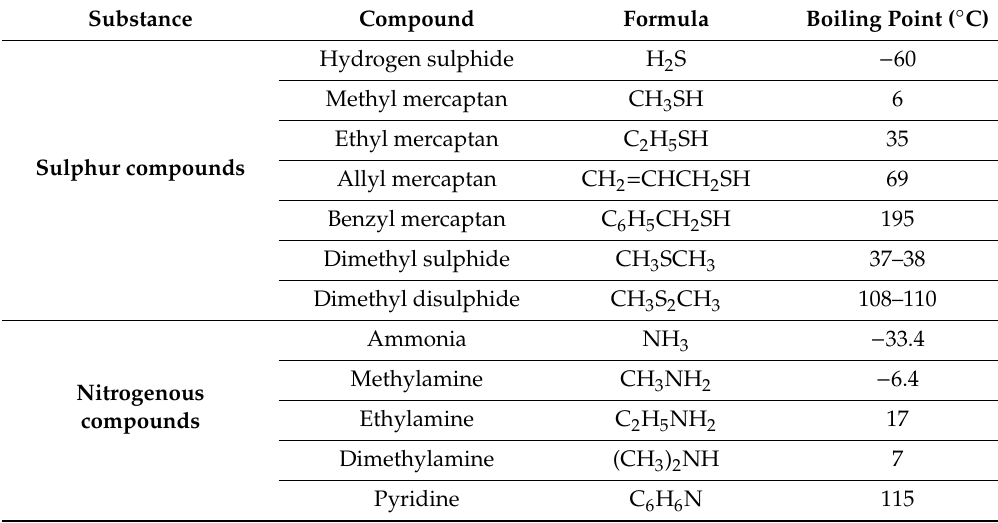
Table 1. Examples of malodorous volatile compounds associated with wastewater (adapted from [29]).